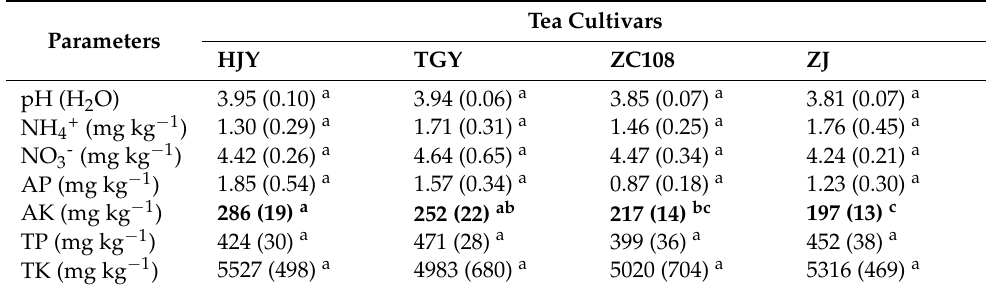
Table 1. Soil chemical properties under different tea cultivars.